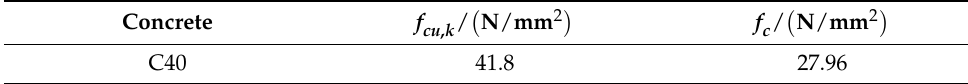
Table 4. Properties of